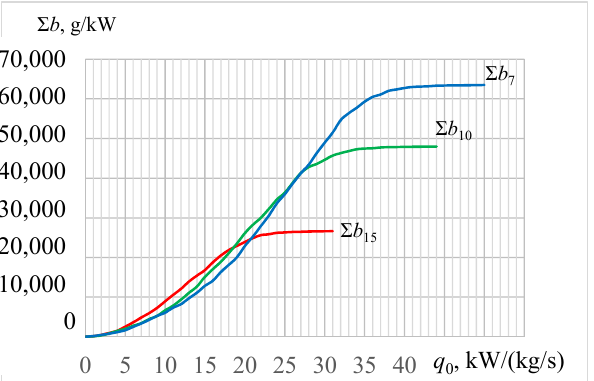
(cid:80) ∆ Figure 7. The annual values of specific fuel reduction ∑Δ b e against specific cooling capacity q 0 at b e against specific cooling capacity q 0 at Figure 7. The annual values of specific fuel reduction different temperatures of cooled air t a 2 : 7 and 10 °C—in AECh; 15 °C—in ACh. di ff erent temperatures of cooled air t a 2 : 7 and 10 ◦ C—in AECh; 15 ◦ C—in ACh.